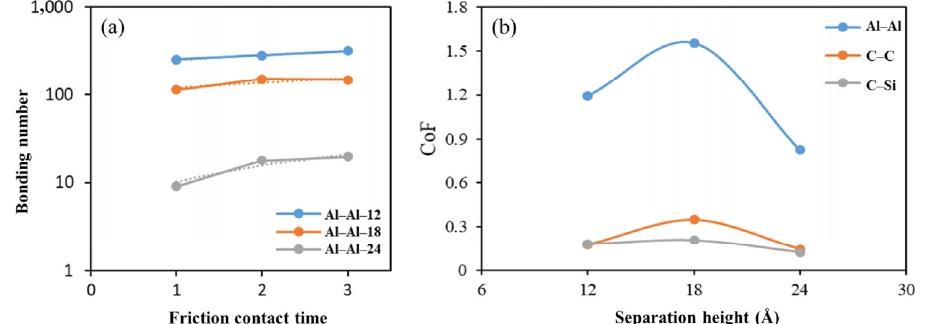
Fig. 7 (a) The worn atomic bonding number of the Al–Al tribo-pairs during the first three friction contacts separated by 12, 18, and 24 Å; (b) theCoFs of Al–Al, diamond–diamond, and the diamond–Si tribo-pairs under the separation of 12, 18, and 24 Å. Note: The “contact time” here refers to the number of contacts of